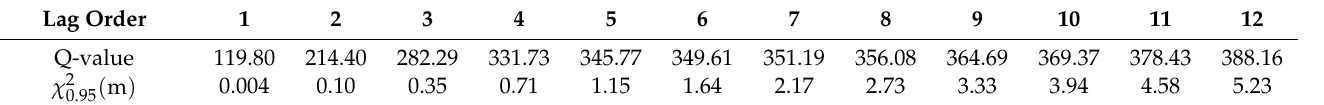
Table 4. Q-value of each lag order.